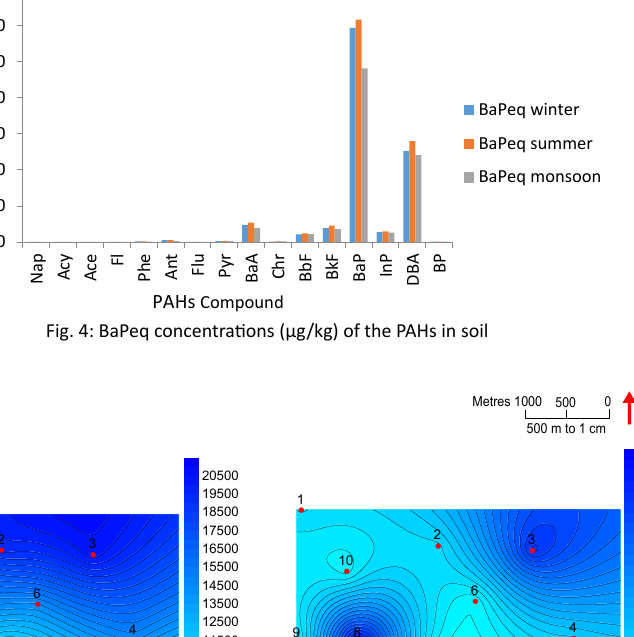
PAH and BaPeq in 16